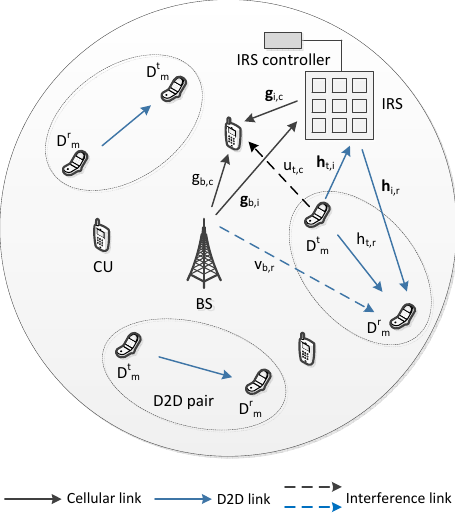
Figure 1. An IRS-assisted D2D underlay communication